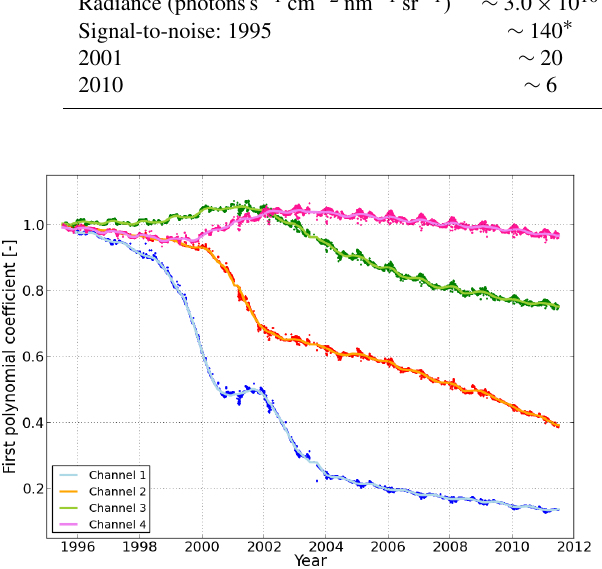
Figure 5. First polynomial coefficient a 0 from wavelength fit as a function of time (small dots, blue: channel 1, red: channel 2, green: channel 3, and magenta: channel 4). The light blue, orange, light green, and light violet curves denote the corresponding smoothed curves using a Savitzky–Golay smoothing filter with a filter width of 250